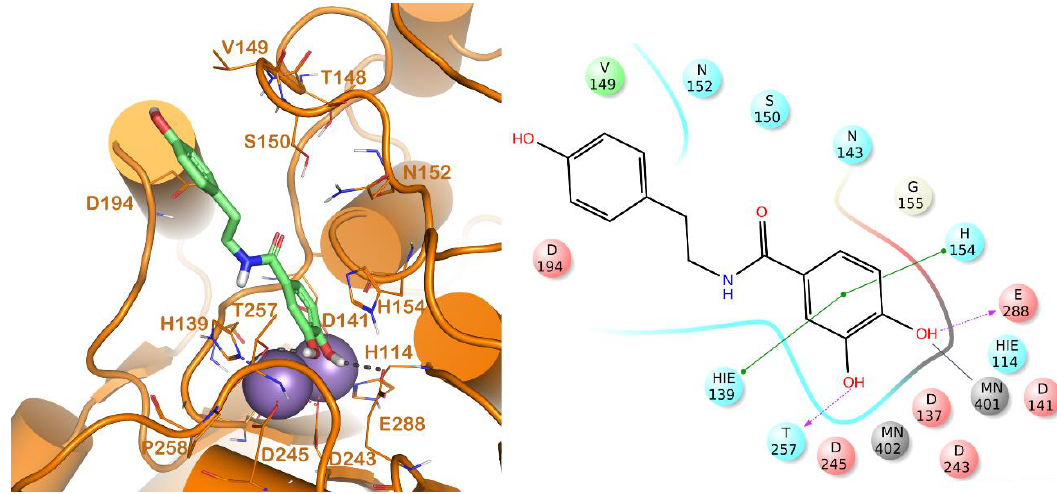
Figure 3. Putative binding mode of compound 17 (light green sticks) into L-ARG binding site (PDB ID